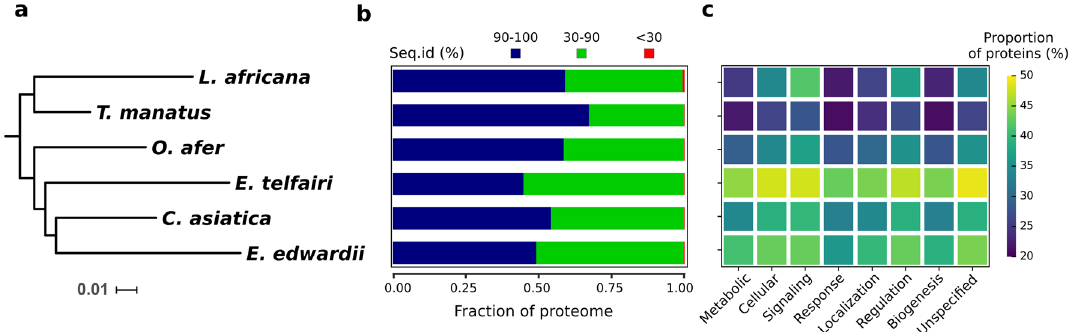
Figure 2. Sequence conservation in Afrotheria. ( a ) Protein sequence-based phylogenetic tree, constructed using concatenated sequence alignments of 20 different proteins, captures relationships between Afrotherian species. The bar at the bottom provides the scale of tree branch lengths. The tree was constructed using maximum likelihood (RAxML) with 1000 bootstrap replicates. ( b ) Bar plot shows the proportions of high (> 90%), moderately (30–90%) and least (< 30%) conserved proteins in the various Afrotherian proteomes (species names on the node tips of ( a ) show the Y-axis). ( c ) Heatmap shows the proportion of moderately and least conserved proteins (sequence identity range of 0–90%) from each species associated with major biological processes. Here also, species names on the node tips of ( a ) show the Y-axis. Color scale for the figure (dark blue- yellow) represents the proportion of moderately and least conserved